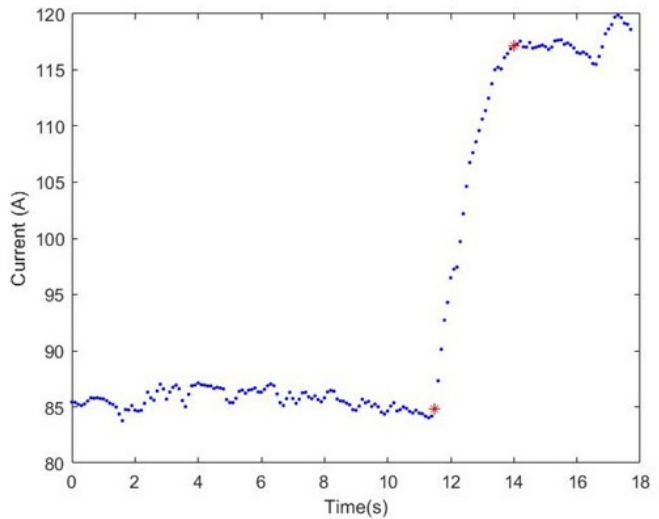
Figure 7. An example of transient throttle data displaying current as a function of time. The endpoints of the transient are marked in red.